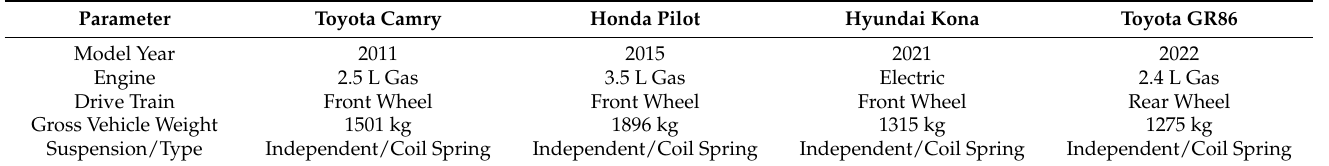
Table 1. Vehicle